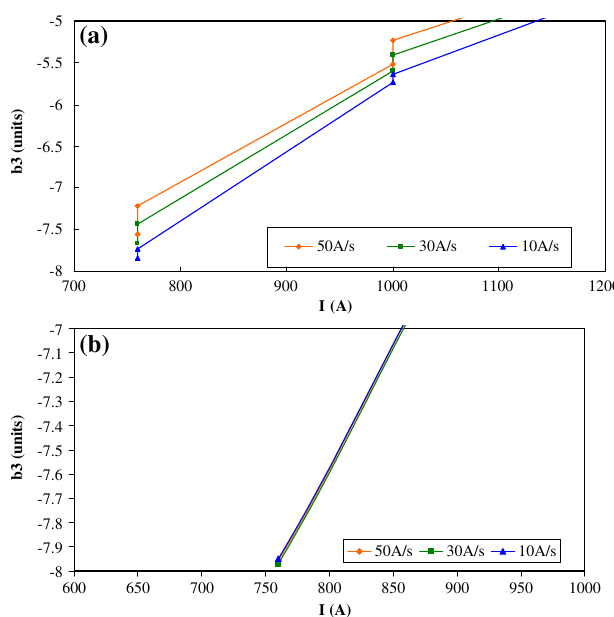
FIG. 9. (Color) (a) Same as Fig. 8. Detail of single measure- ments for the loadline data reported in Fig. 8 (MB2598 aperture 2) with different precycle ramp rates around 760 A. (b) Loadline measurements after